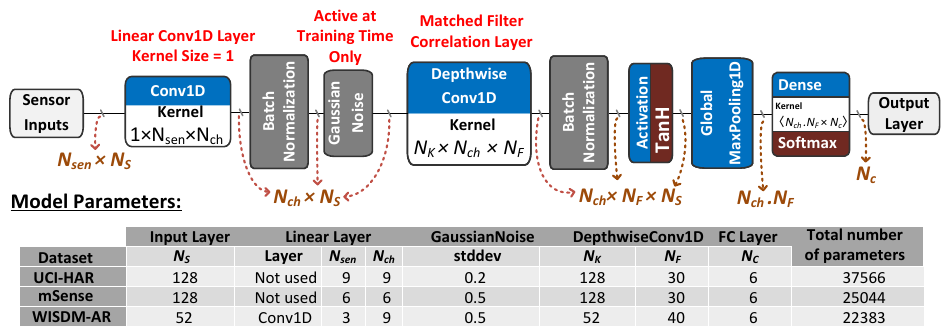
Figure 6. Multivariate MF CNN